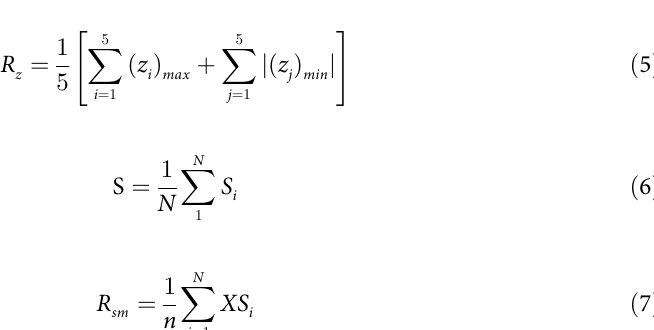
Notch parameters a , b and notch spacing d can be converted by the 10-point roughness parameter R of standard surface roughness parameter, the single-peak average distance S of z of peak and valley profiles. It can be seen from the above contour and the average interval R sm mathematical expressions that the surface roughness parameters such as R